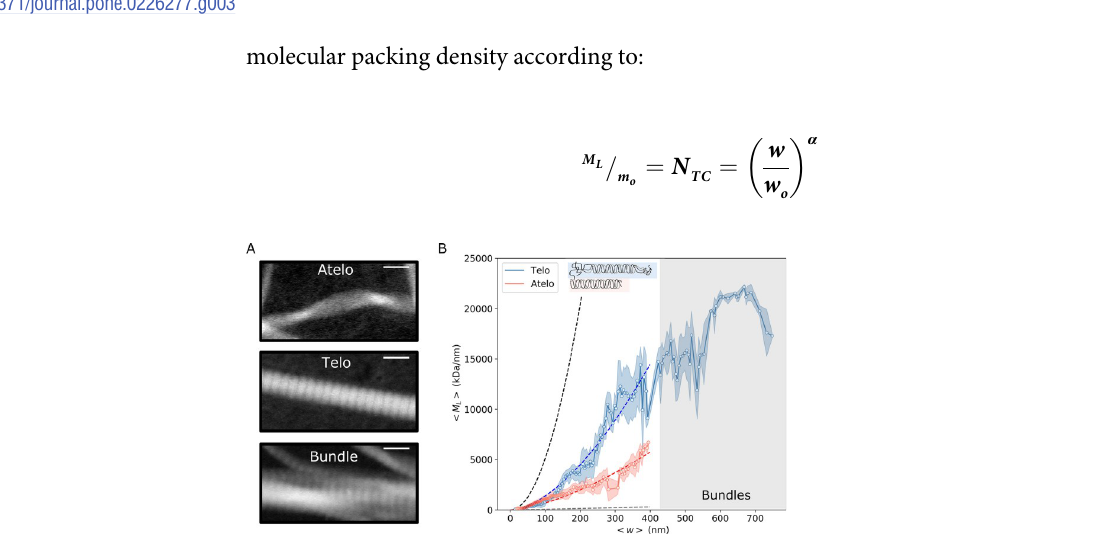
Fig 4. Collagen fibril packing. (A) HAADF images of representative fibrils from atelo- and telo-collagen. The bottom row shows an example of a bundle where multiple telocollagen fibrils join. Scale bar 200 nm. (B) Average M L values as a function of average fibril width, w , for telo- (blue) and atelo- (red) bovine collagen type I. The dotted lines show the expected M L values from Eq. (1) for α = 2 (black) and α = 1 (gray), and the fits with α = 1.687 and α = 1.525 for telo- (blue) and atelo-(red) collagen, respectively. Fibers in the grey-colored region are all bundles. The error bars represent the standard deviation. n = 15695 (telo-) and n = 41730 (atelo-collagen) segments.